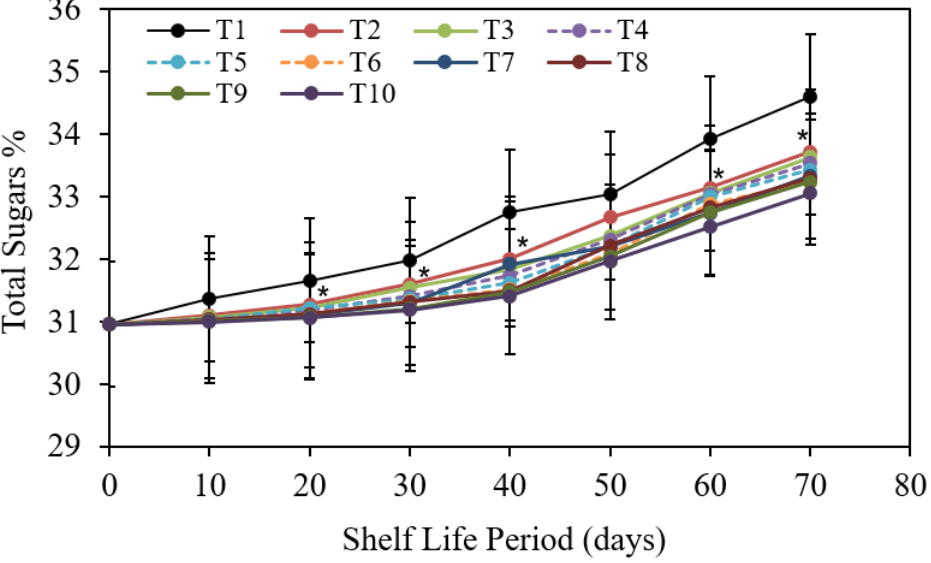
Figure 10. The impact of pre-harvest chitosan, chitosan nanoparticle, and CaCl 2 foliar spray treatments on total sugars of Barhi date fruits under cold storing for 70 d. Note that * sign denotes the significant differences between the control and edible coatings treatments, and T1, T2, T3, T4, T5, T6, T7, T8, T9, and T10 are water (control), 1 g/L chitosan, 2 g/L chitosan, 3 g/L chitosan, 1 g/L